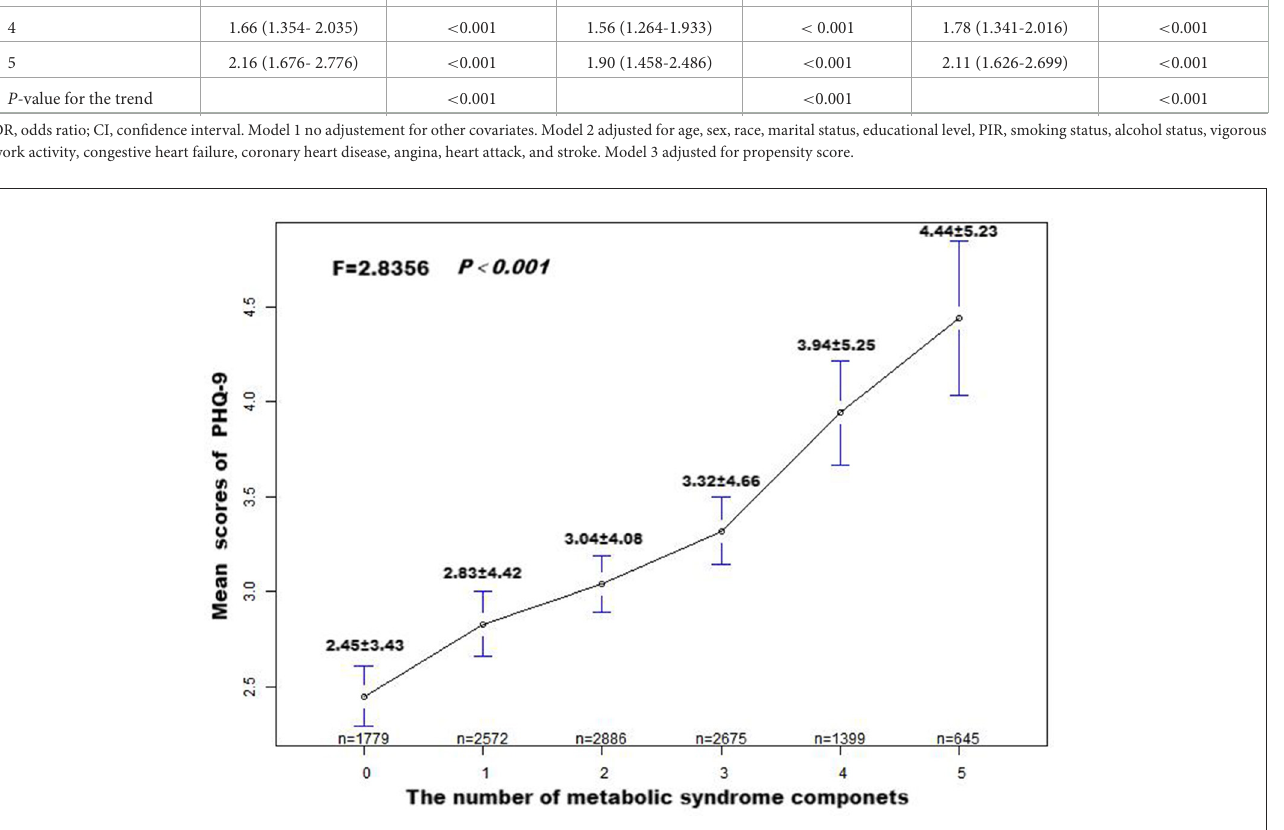
statistical analysis, and P < 0.05 was considered for defining statistical